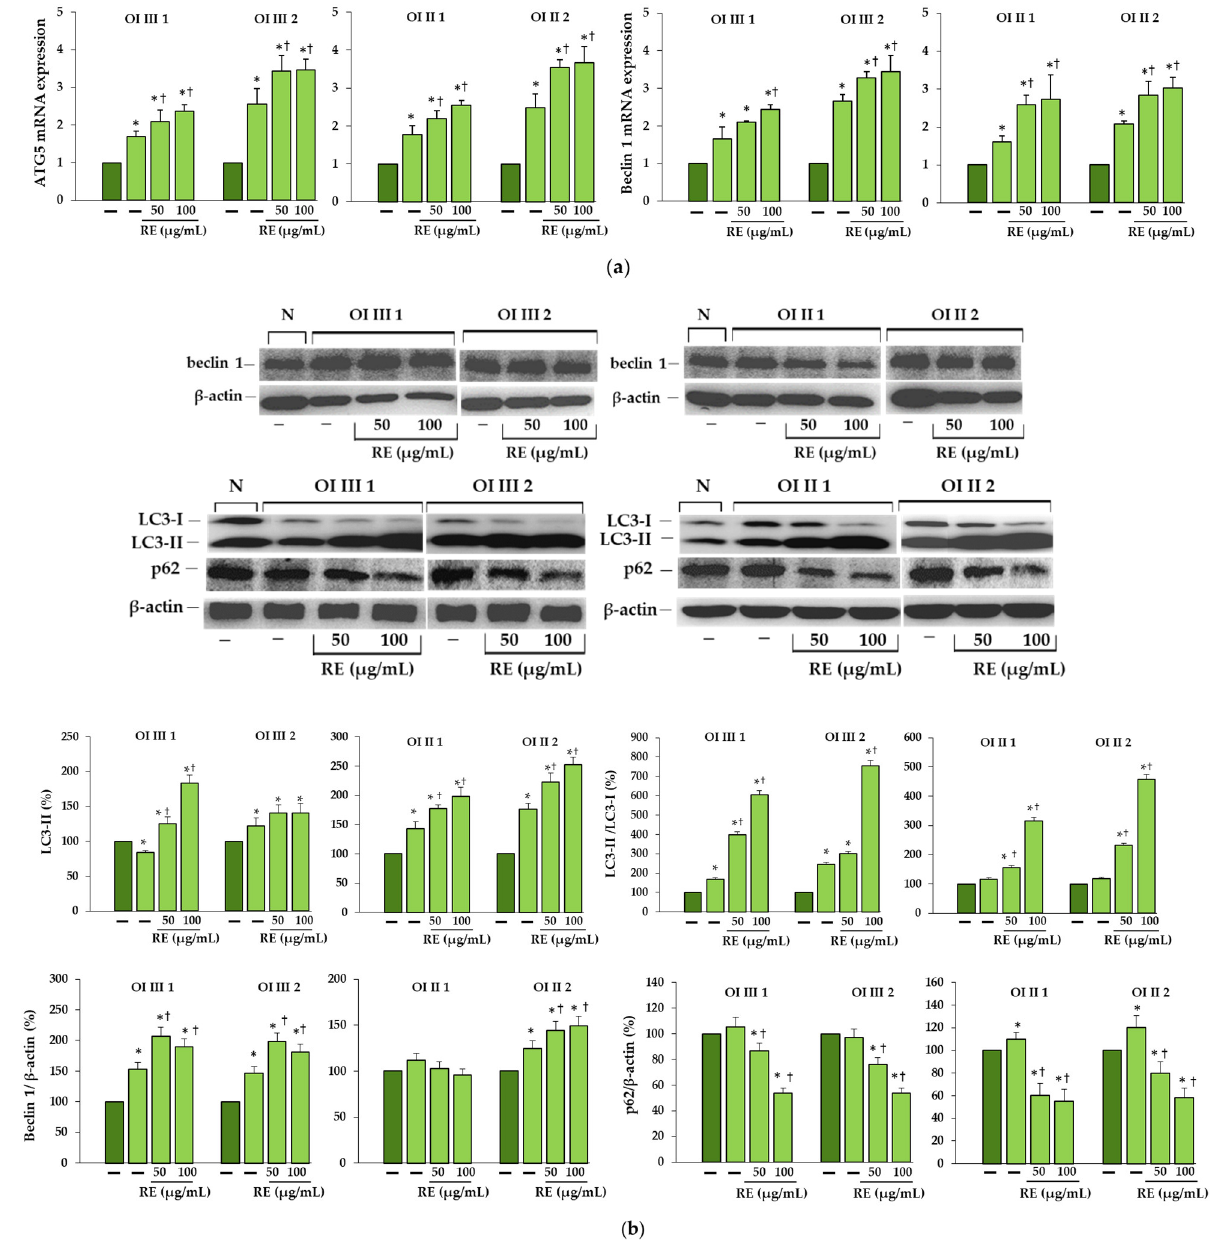
Figure 4. ( a ) The influence of rosemary extract (RE) on mRNA relative expression of autophagy- related gene (ATG5) and beclin 1 in OI types III and II cells. The bars represent the results of the mean values from three independent experiments; * p < 0.05, OI cells vs. normal cells; † p < 0.05, OI treated cells vs. OI untreated cells; dark green and light green bars represent normal and OI, respectively. ( b ) Western blot analysis of beclin 1, microtubule-associated protein 1 light chain 3 (LC3-I/LC3-II), and sequestosome 1 (SQSTM1/p62) in OI type III and II cells; β-actin was used as cell protein loading control. The bars represent the results as the mean values from three independent experiments; * p < 0.05, OI cells vs. normal (N) cells; † p < 0.05, OI treated cells vs. OI untreated cells. The data are expressed as a percentage of the normal sample taken as 100%; dark green and light green bars represent normal and OI, respectively.